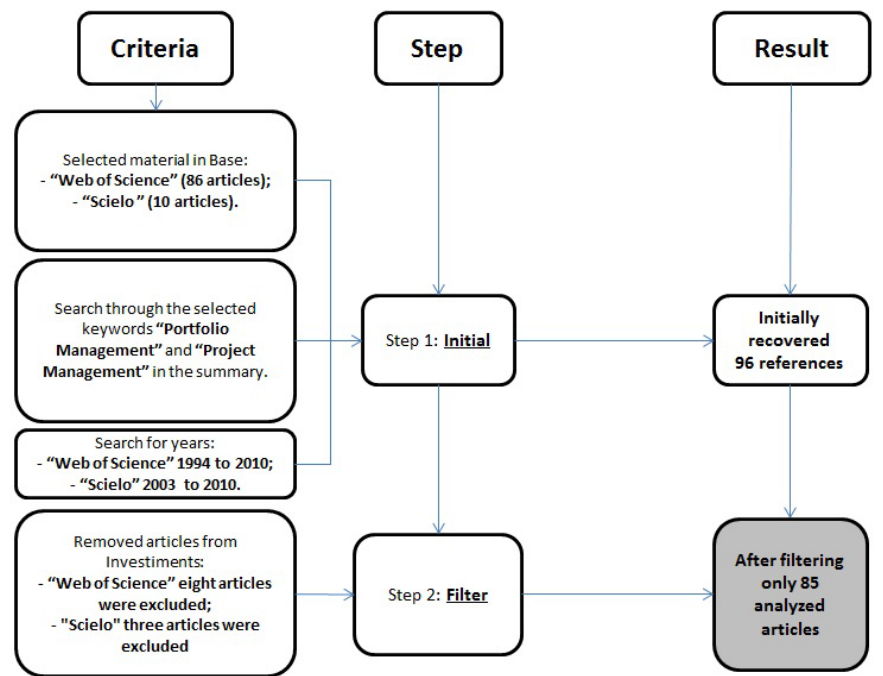
Figure 1. Phases of bibliomtric research between 1994 and 2010 (based on Carvalho et al.,